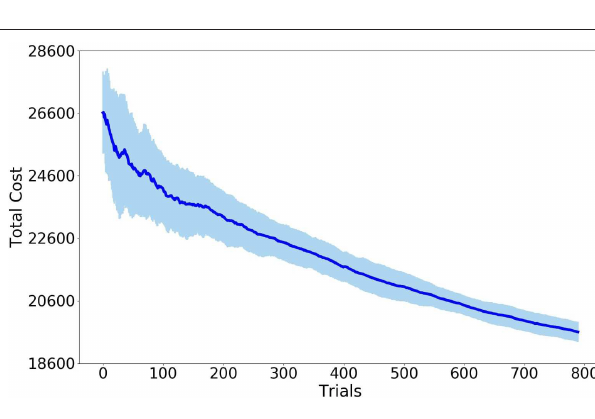
FIGURE 8 | Error-bar curve of cost values with Procrustes distance as imitation metric. The solid line denotes mean values while the light blue represents the standard deviation. All quantities are expressed in